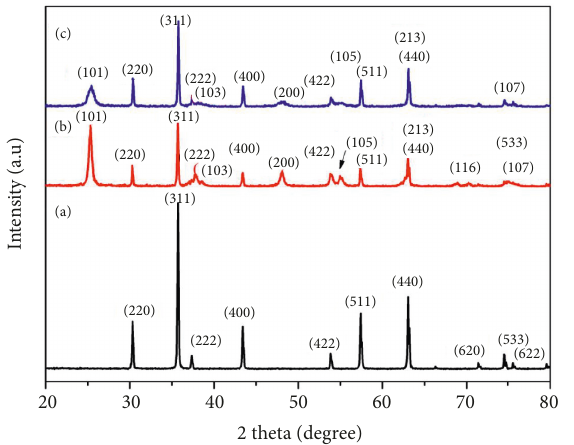
Figure 1: XRD patterns of (a) NiFe 2 O 4 , (b) NiFe 2 O 4 @TiO 2 , and (c) NiFe 2 O 4 @TiO 2 @rGO core@shell nanoparticles.